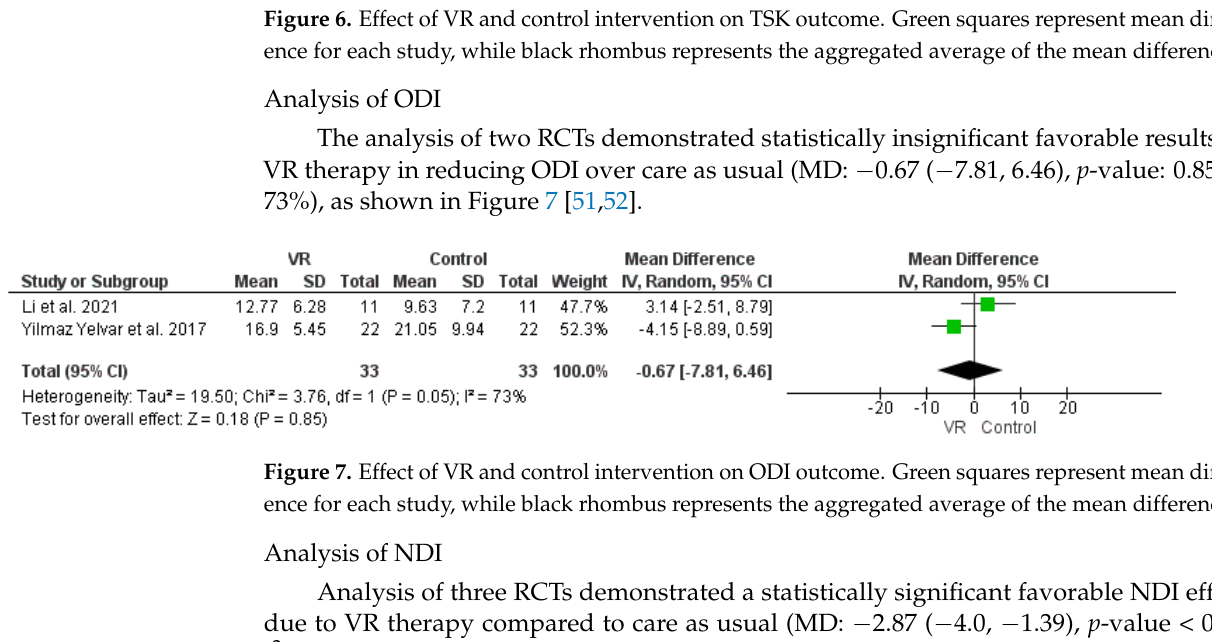
the mean differences.